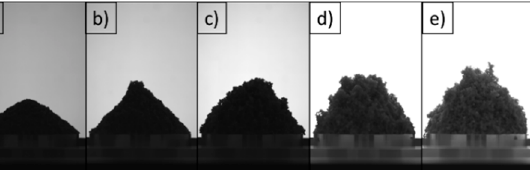
Figure 3. Static angle of repose as a function of the added mass fraction for mixtures with water and R812S.